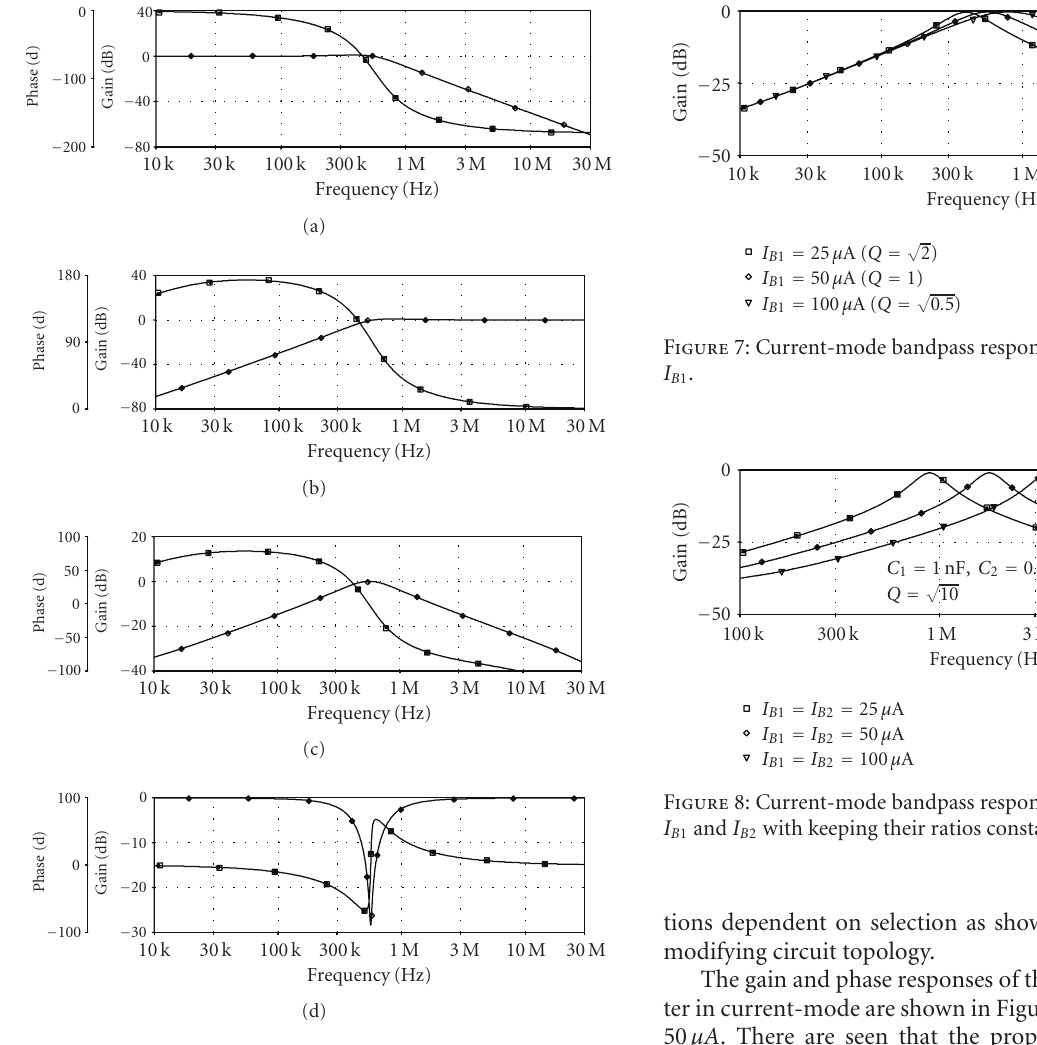
calculated value of this parameter from (6) is 612.45 kHz.